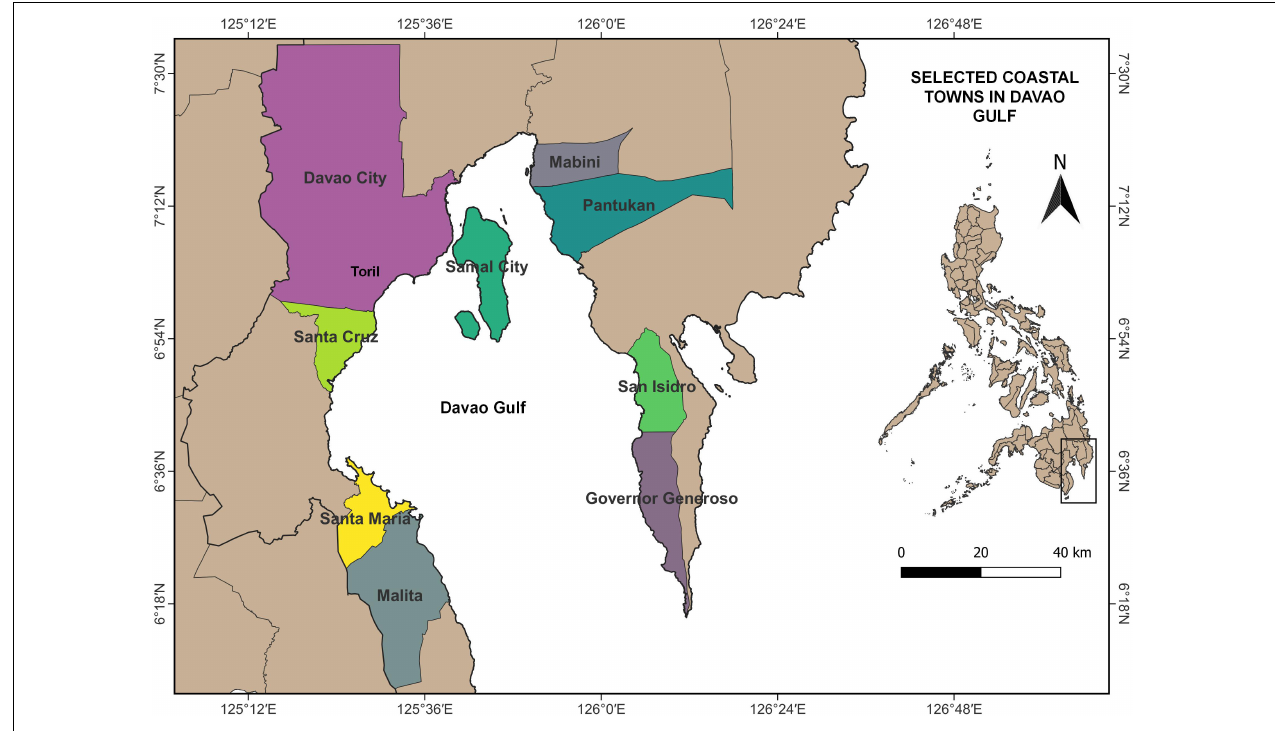
FIGURE 1 | The study sites around the Davao Gulf where the impact of COVID-19 surveys were conducted with small-scale fishers (SSF) and their families.